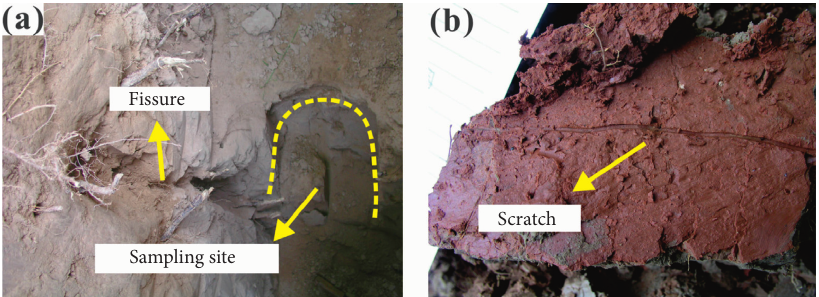
Figure 3: Photos showing the sliding site from different locations. (a) The loess sample from the slip zone. (b) Scratch on the slip zone.